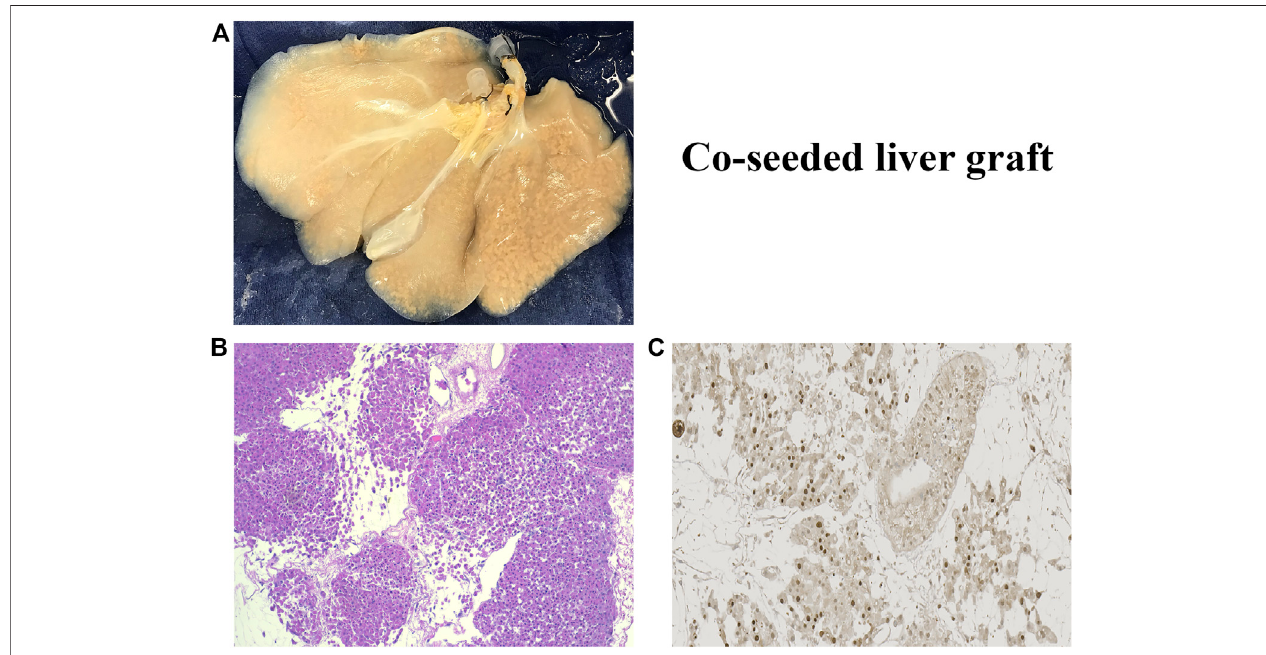
FIGURE3|(A) .Decell-recelllivergraftco-seededwithHUVECendothelialcellsandprimaryhepatocytes. (B) .Lightmicroscopyofco-seededgraftshowinglobular structure after reseeding (H&E staining). (C) . IHC microscopy of co-cultured graft showing mitotically active cells after reseeding (Ki67 staining).